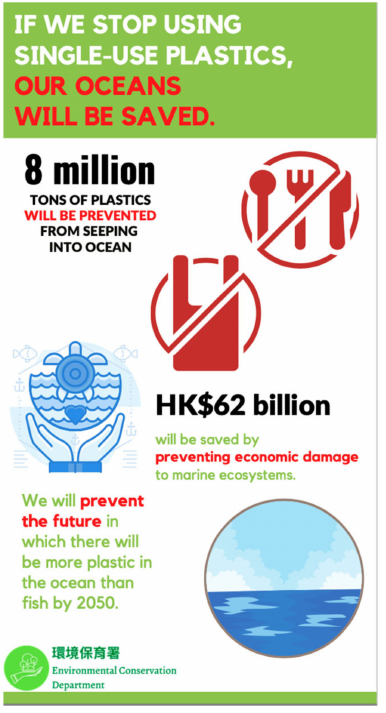
Figure A10. Example of condition 10: gain * infographic *